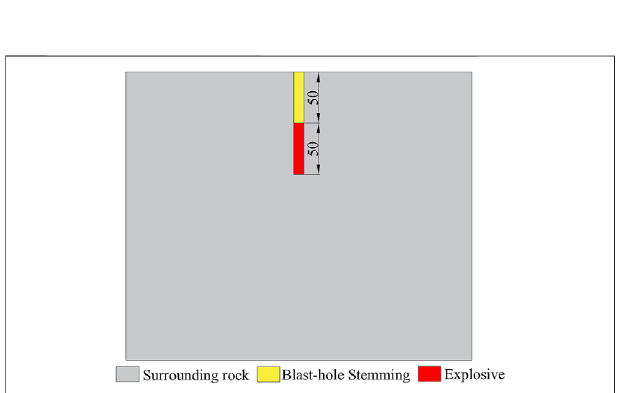
FIGURE 3 | Finite element model (unit: m).